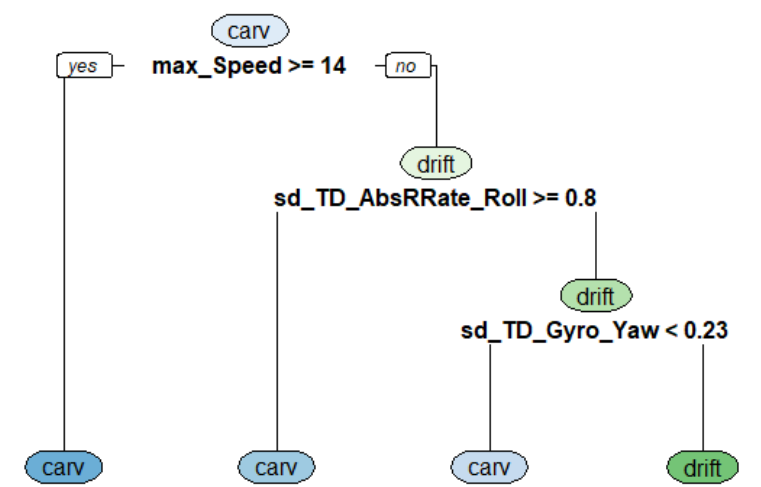
Figure A2. Decision tree for the classification of the parallel turns (max_Speed = maximum speed of turn, sd_TD_AbsRRate_Roll = standard deviation of absolute roll axis angular velocity of turn, sd_TD_Gyro_Yaw = standard deviation of gyroscope roll axis angular velocity of the turn).